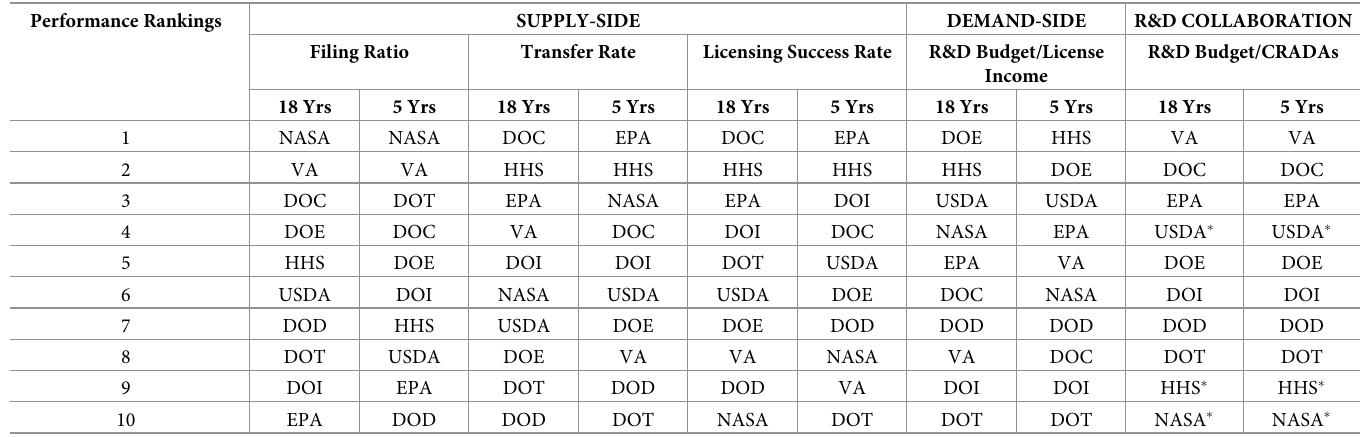
Table 6. Agency technology transfer